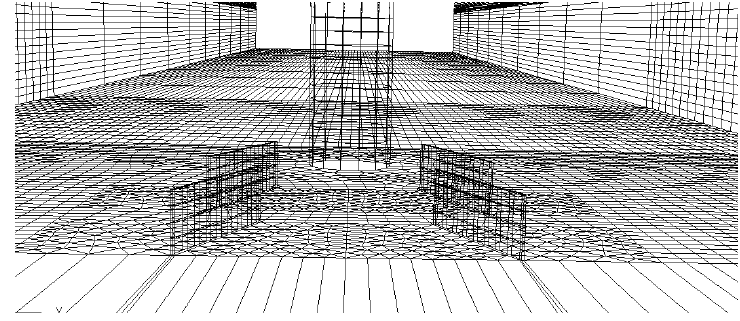
Fig. 3. Grid for pier area and four submerged